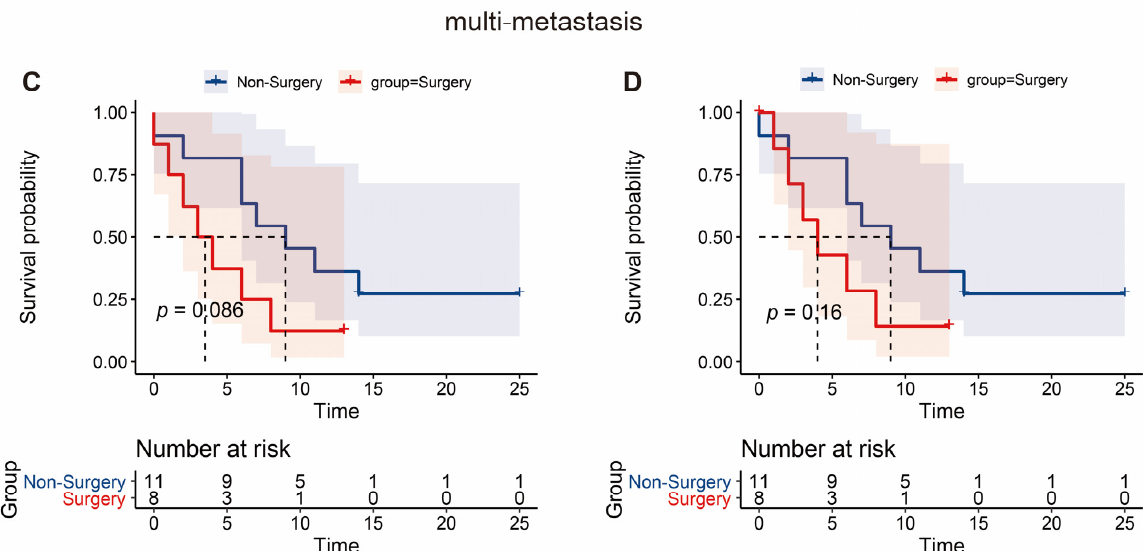
Figure 4. Survival analysis of patients with oligo- and multi-metastasis. The Kaplan–Meier analysis of overall survival ( A ) and cancer-specific survival ( B ) in PDAC patients with oligo-metastasis. Similar analysis of overall survival ( C ) and cancer-specific survival ( D ) in multi-metastatic PDAC patients.